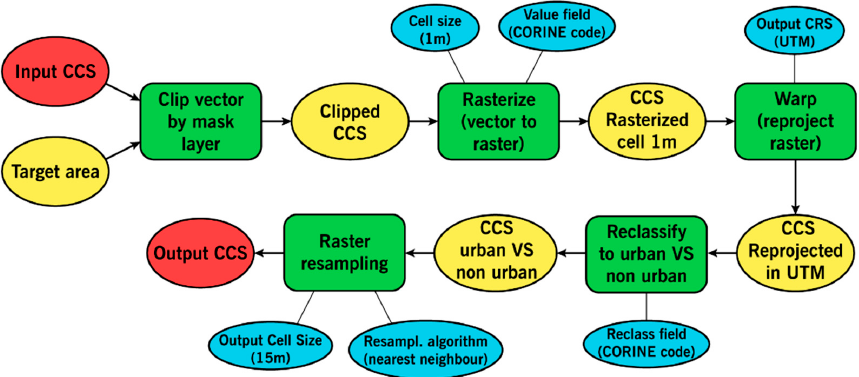
Figure 5. The complete processing workflow applied to the CCS (Carta di Copertura del Suolo) for accuracy assessments. We ran all the workflow within the QGIS environment, by means of GDAL and SAGA